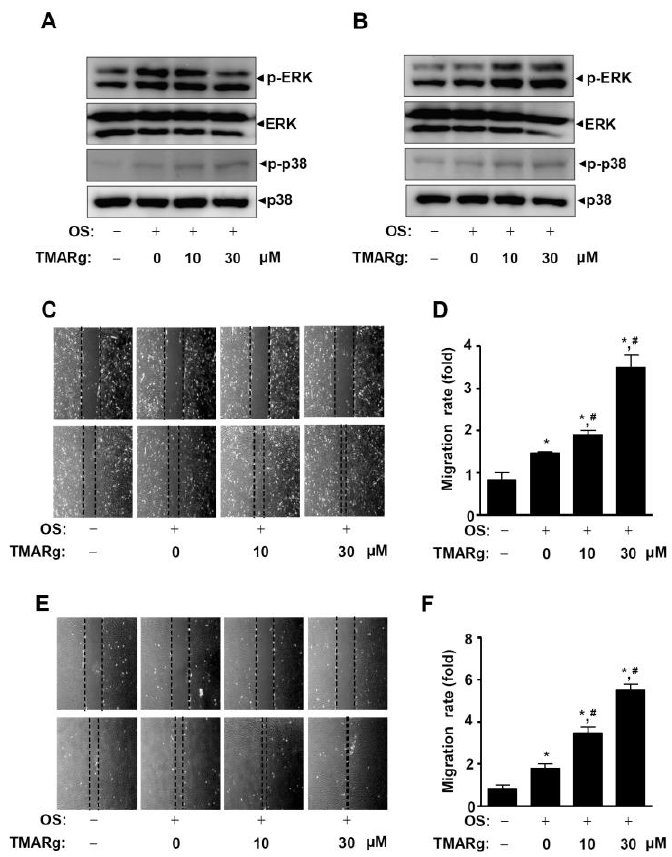
Figure 6. TMARg activates MAPKs signaling and promotes the cell migration rate in osteoblast differentiation. ( A , B ) After mesenchymal cells ( A ) and pre-osteoblasts ( B ) were cultured in OS with TMARg (10 and 30 µM) for 24 h, phospho-ERK1/2, ERK1/2, phospho-p38, and p38 were analyzed using Western blot analysis . ( C – F ) Cell migration in mesenchymal cells ( C , D ) and pre-osteoblasts ( E , F ) was observed under a phase contrast microscope ( C , E ), and the cell migration rate (fold) was measured by the area enclosing the spreading cell population and expressed as a bar graph normalized to the control ( D , F ). The data are representative of the results of three independent experiments. Data represent the means ± SEMs of experiments. *, p < 0.05 was considered significantly different, compared to the control. #, p < 0.05 was considered significantly different, compared to the OS.